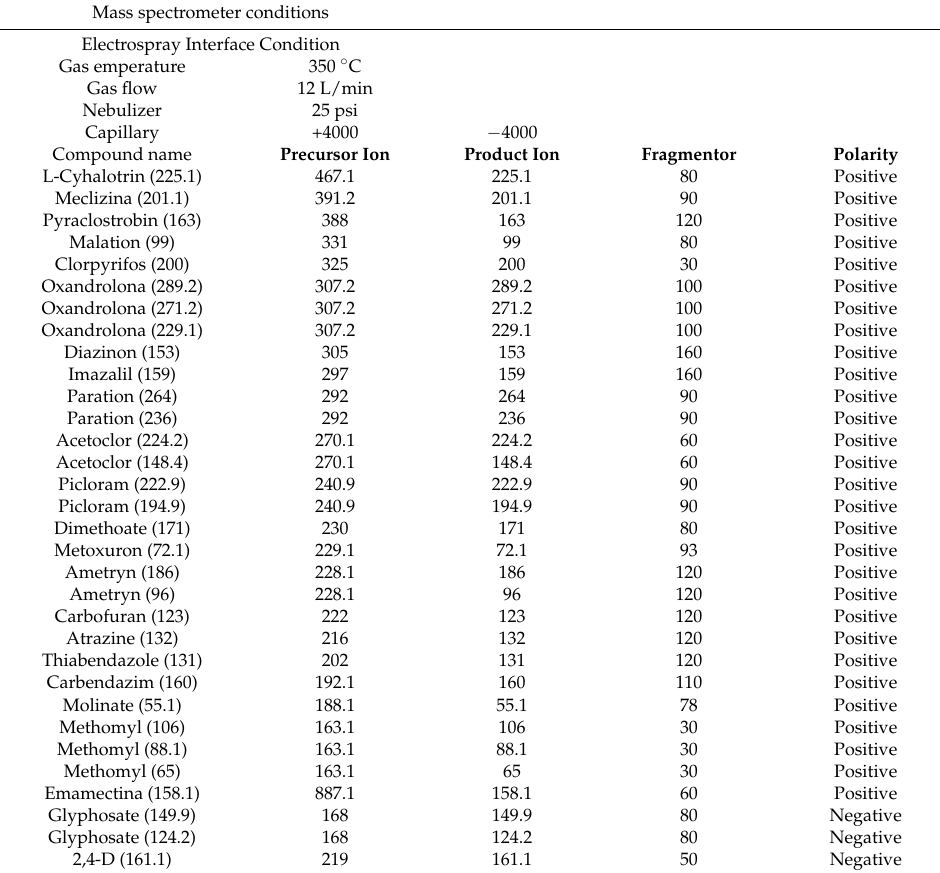
Table 2. Mass spectrometer conditions for pesticide